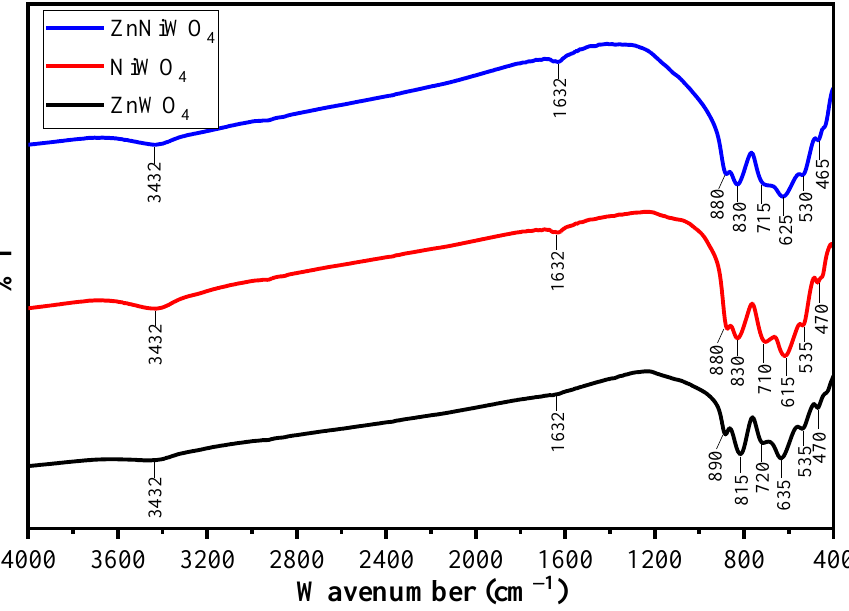
Figure 1. FTIR spectra of ZnWO 4 (black line), NiWO 4 (red line), and ZnNiWO 4 (blue line).